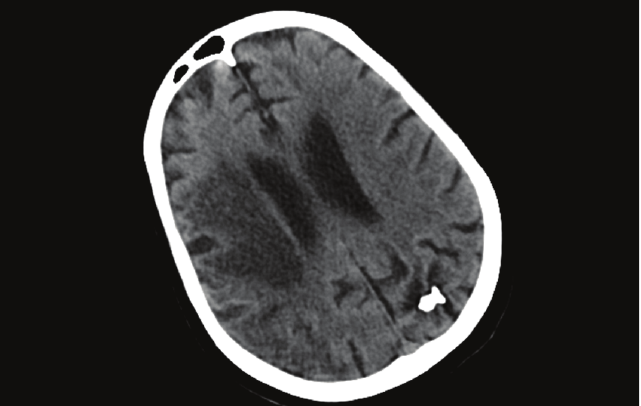
Figure 2. IAt the lateral ventricle level, there is a large density reduction in gray and white matter in the parietal and occipital lobes, and there is no evidence